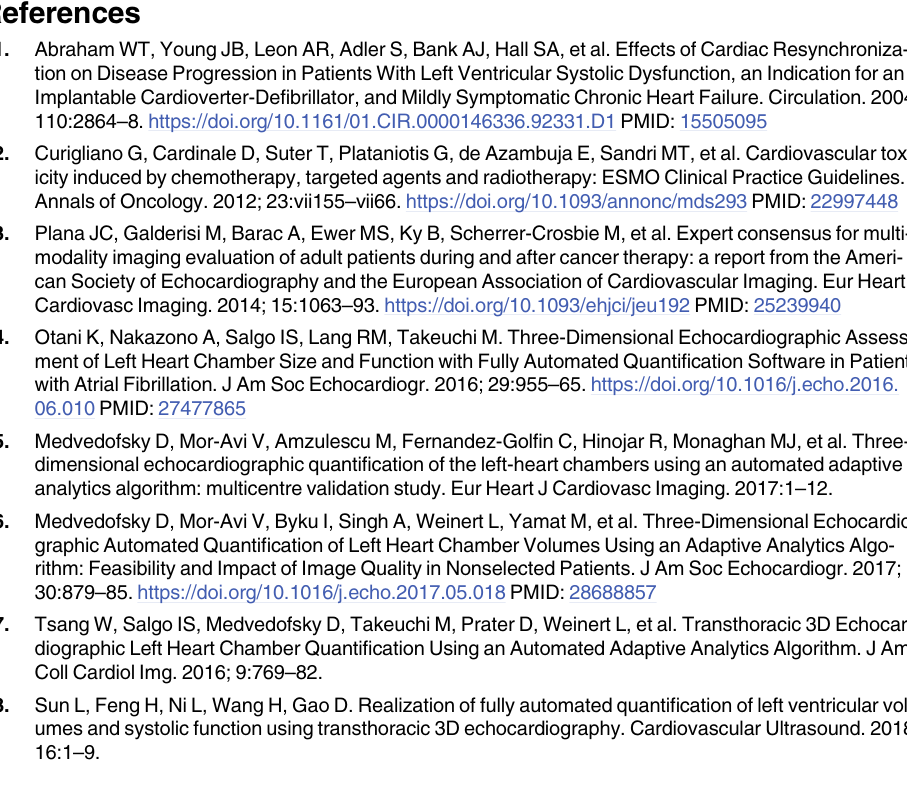
S1 Table. Analysis of correlation, bias, 95% LOA and CP between HeartModel with serial border setting and CMR disk-area summation method. S2 Table. Analysis of correlation, bias, 95% LOA and CP between HeartModel with serial border setting and CMR FT